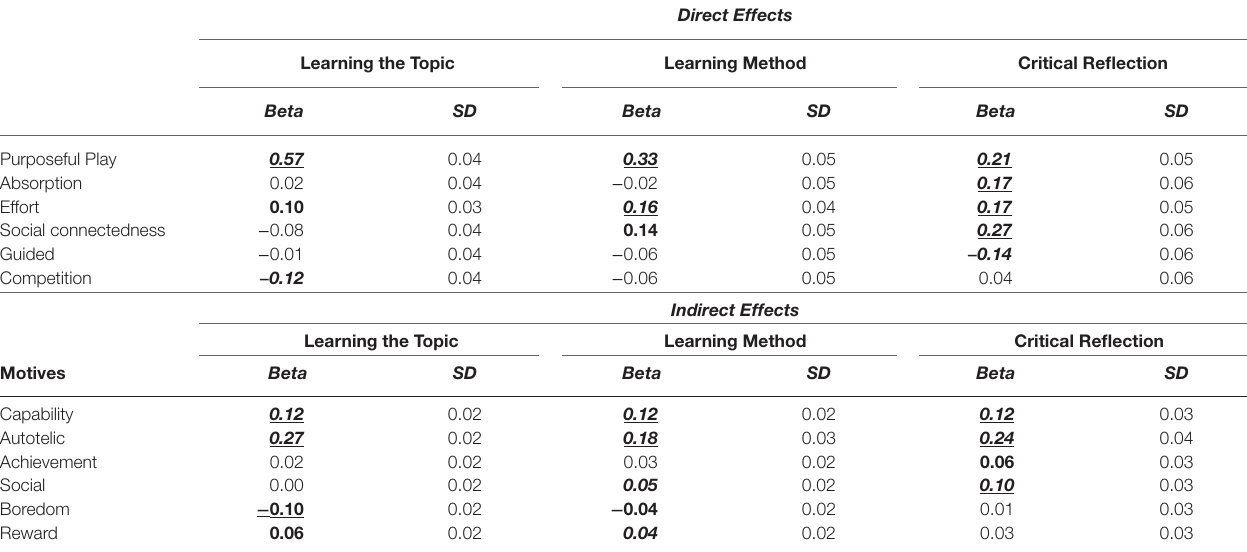
FIGURE 2 | Structural model for investigating the direct effects of experienced gamefulness and indirect effects of explicit motives on learning TABLE 8 | The direct effects of experienced gamefulness and indirect effects of motives on learning.